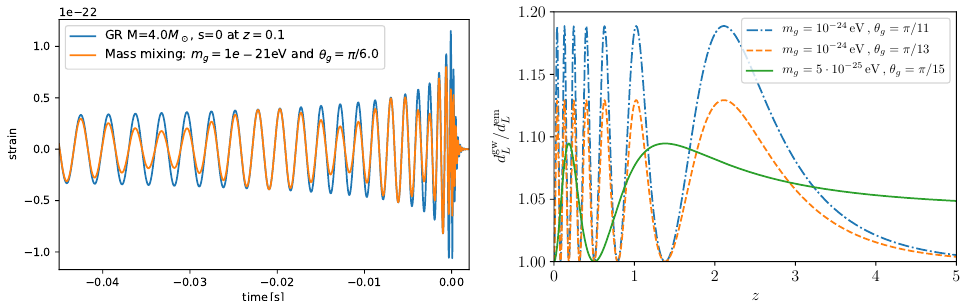
Figure 3. From [16]. The left panel shows a clear signature of the mixing of GWs with an additional helicity-2 mode mediated by a non-trivial background due to R shows a possible signature in the luminosity distance. The plots correspond to different masses and angle